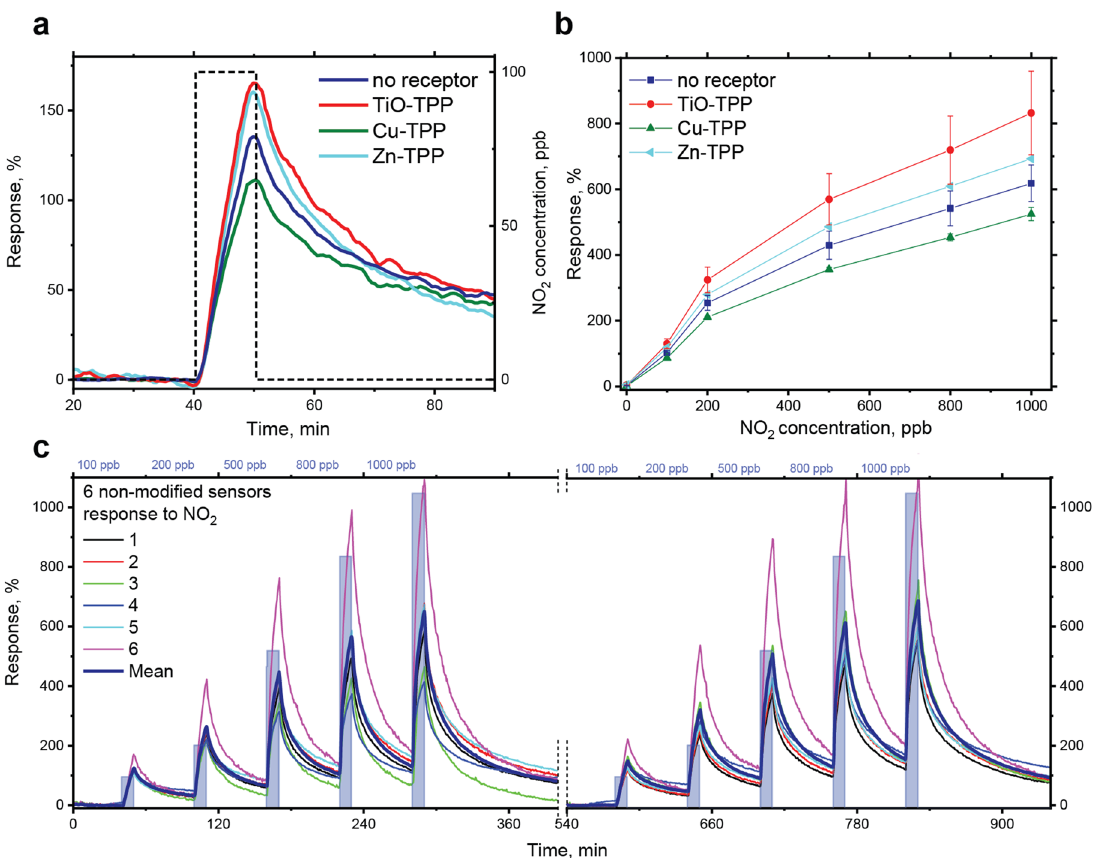
Figure 3. Effect of the receptor layer on the response selectivity, response reversibility and reproducibility. ( a ) Mean response of the sensor groups with different receptor layers: TiO-, Cu-, Zn-TPP and sensors without receptor layer towards 100 ppb of NO 2 in humid air with 95% RH. ( b ) Response curves to NO 2 at 95% for the non-modified OFET sensor and the devices with TiO-, Cu- and Zn-TPP receptor layers demonstrating their effect on the response selectivity. Mean values are presented with their standard errors. ( c ) Response-time (left axis) dependence for 6 non-modified OFET sensors of the array on a single substrate for 2 successive experiments in humid air at 95% RH (color lines) and its mean value (bold blue line) with NO 2 pulses from 100 to 1000 ppb shown in light